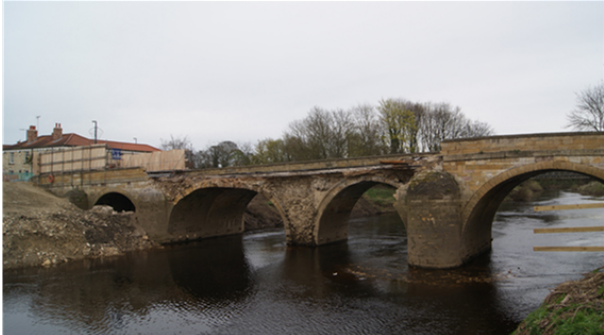
Figure 3. Tadcaster Bridge, damaged by Storm Eva in 2015, repaired and reopened to traffic 13 months after. Bridge clo- sure resulted in a 9mi (14.5km) detour of 20min to reach the other side. Source: https://commons.wikimedia.org/wiki/File: Tadcaster_Bridge_closed_following_last_years_damage_(10th_ April_2016)_005.JPG (last access: 3 March